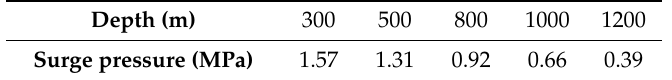
Table 5. Surge pressure at the bottom hole as the pipes trip in under different depths. Depth (m) 300 500 800 1000 1200 Surge pressure (MPa) 1.57 1.31 0.92 0.66 0.39